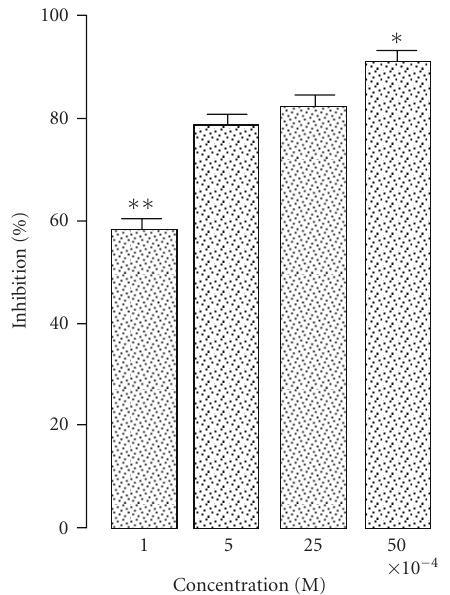
Figure 1: E ff ect of Z-pro-prolinal on soluble prolyl oligopeptidase activity of thioglycollate-elicited murine macrophages. The values (means ± SEM from 5 animals) were recorded in triplicate as the percentage of inhibition relative to control reactions (enzyme activ- ity = 100%, percentage of inhibition = 0) which run simultaneously in absence of Z-pro-prolinal. All concentrations of Z-pro-prolinal produced lower levels of enzyme activity when compared to the control (unpaired two-sided Student’s t -test, P < . 05). ∗ P < . 05 in comparison to 5 × 10 − 4 M or 25 × 10 − 4 M ; ∗∗ P < . 001 in comparison to all other concentrations of Z-pro-prolinal (analysis of variance, ANOVA, followed by SNK test).